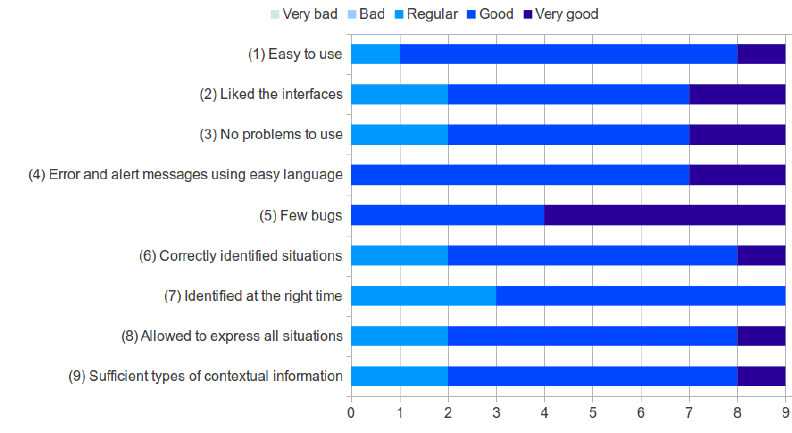
Figure 8. Results from the